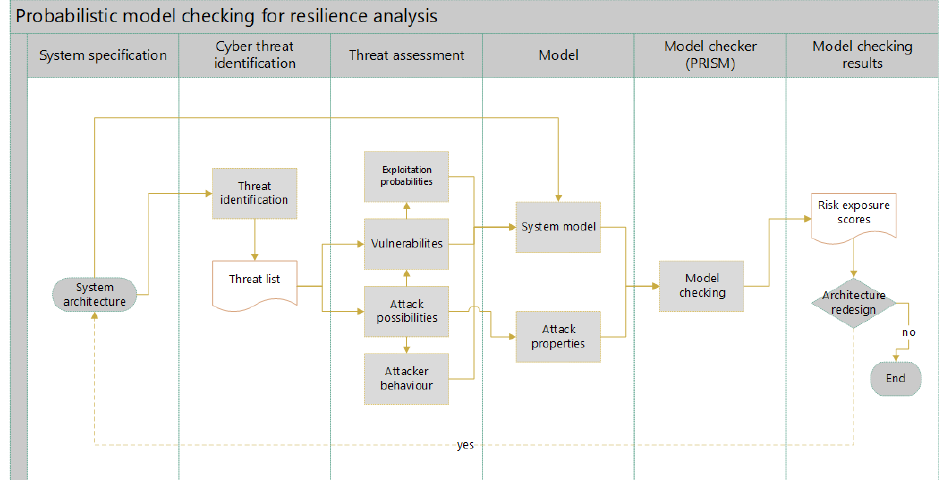
Figure 3. Proposed methodology for the resilience analysis based on probabilistic model